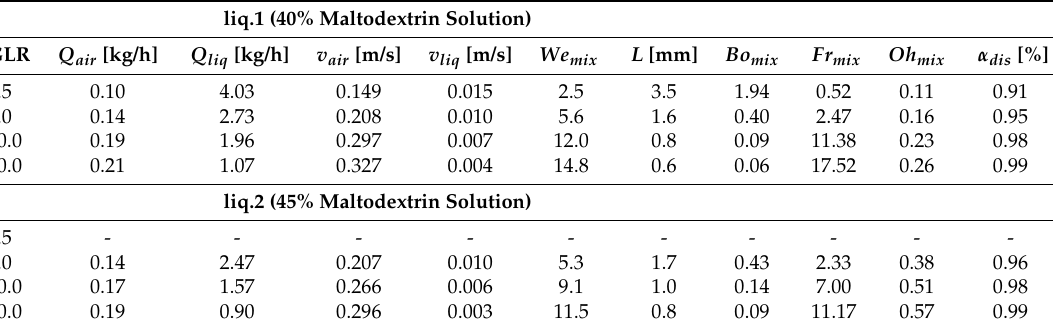
Table 4. Working parameters of the OIG nozle.